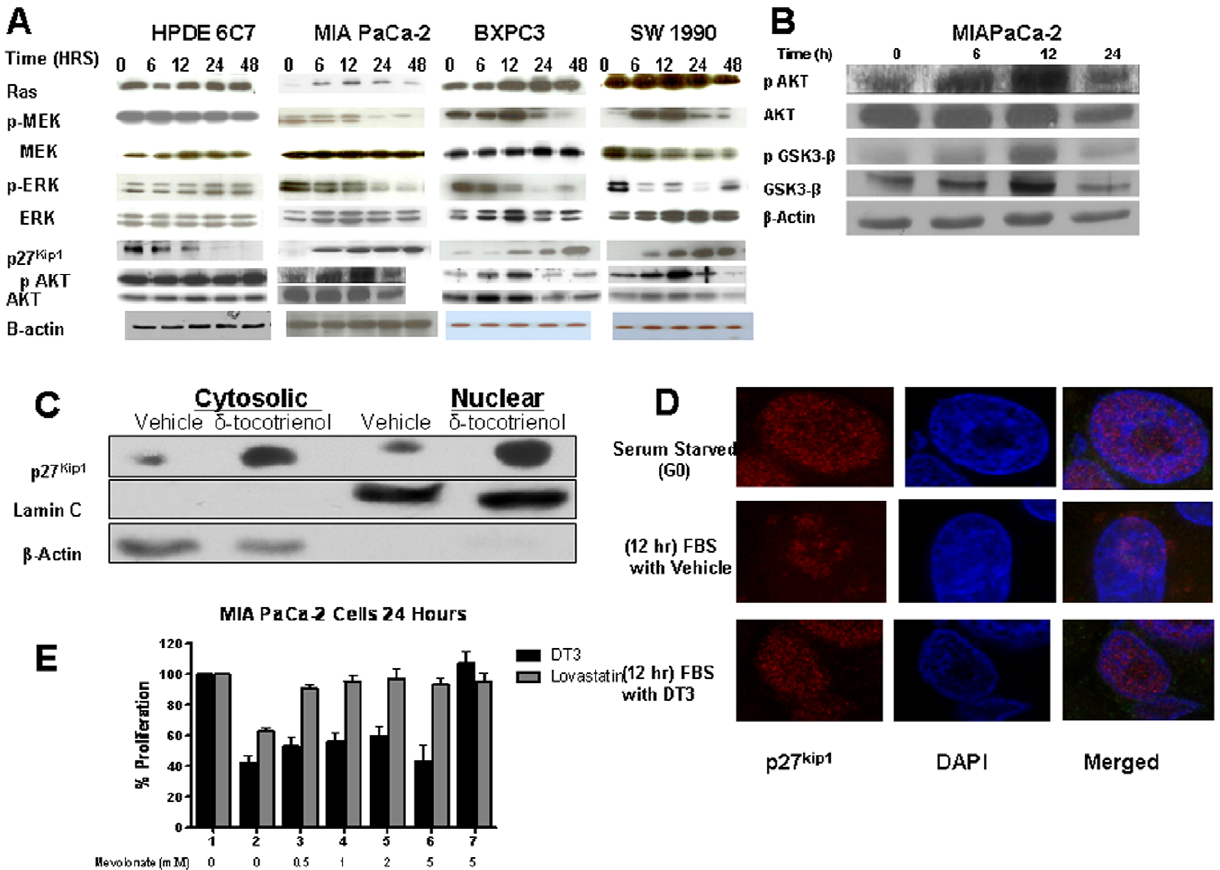
Figure 2. d -Tocotrienol induces p27 Kip1 expression and inhibits RAS-MEK-ERK signaling. A , pancreatic cancer and HPDE6 C7 cells were treated with d -tocotrienol at predetermined IC 50 for each cell line. Protein lysates from 0–48 hours were collected and analyzed by Western blot analysis for Ras oncogenic signaling targets, MEK and ERK, and p27 Kip1 . Results are representative of 3 independent experiments. d -Tocotrienol selectively inhibits MAP kinase signaling and increases p27 Kip1 expression in transformed pancreatic cancer cells. B, MIAPaCa-2 cells were treated with d -tocotrienol at predetermined IC 50 . Protein lysates from 0–24 hours were collected and analyzed by Western blot for AKT and a downstream target GSK-3 b . C , MIAPaCa-2 cells were treated with vehicle or d -tocotrienol in FBS for 12 hours, and pure nuclear and cytosolic fractions were isolated. Western blots show increased levels of p27 Kip1 in d -tocotrienol treated cells with high concentrations in the nucleus. D, simultaneously, whole cells were stained with immunofluorescent p27 Kip1 antibody and analyzed by fluorescent microscopy for p27 Kip1 localization. d -Tocotrienol localized p27 Kip1 to the nucleus similar to the starved state, whereas serum-treated cells showed equal levels of p27 Kip1 in the nucleus and cytoplasm. E, d - tocotrienol (DT3) suppresses tumor cell growth of MIAPaCa-2 cells in the presence of added mevalonate, a metabolite of HMG-CoA reductase. MIAPaCa-2 cells (in 96-well plates) were treated for 24 hours with d -tocotrienol or lovastatin in the absence or presence of increasing concentrations of mevalonate. MTT results demonstrate that mevalonate rescues the growth inhibitory effects of lovastatin, but not that of d -tocotrienol. In E , lines 1 and 7 had no d -tocotrienol (DT3) or lovastatin.